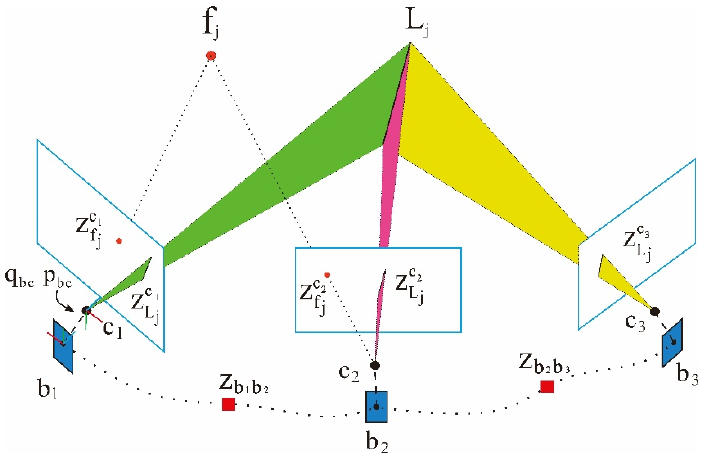
Figure 2. An illustration of visual–inertial odometry. Visual observations: point observations and line measurements. IMU observations: inertial measurement unit measurements.